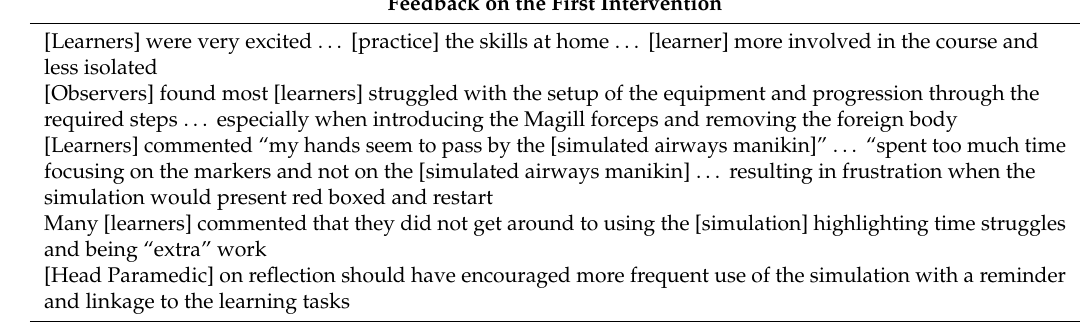
Table 5. Data Supporting “Revise and reflect” step of the Pedagogy before Technology model, as per Figure 3. Feedback on the First